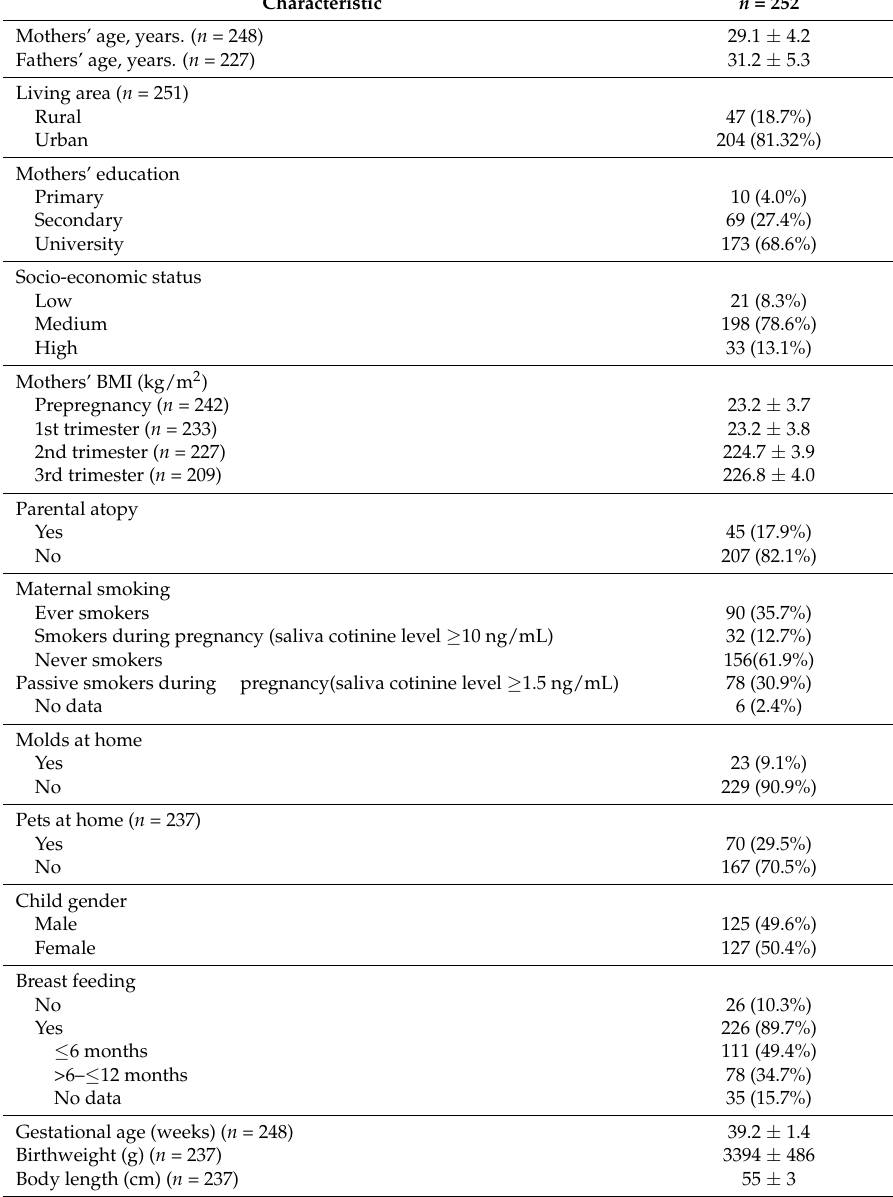
Table 1. Characteristics of the pregnant women and anthropometric measures of their neonates.